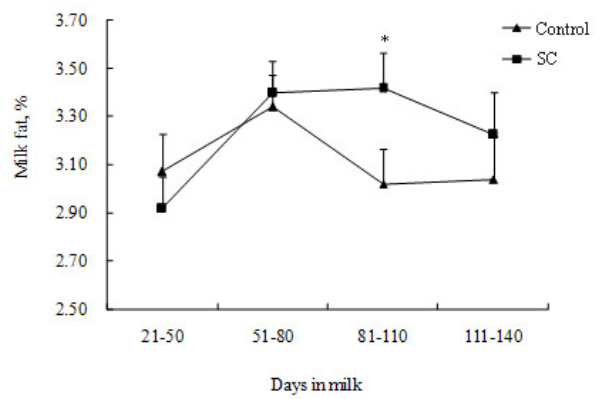
Figure 1. Interaction between SC and DIM on percentage of milk fat (Farm 1). SC was fed at 56 g/cow/d (Diamond V Original XP, Diamond V, Cedar Rapids, Iowa, USA). Note: symbol on the top of standard error bars indicate the significance of the differences between data for control and SC